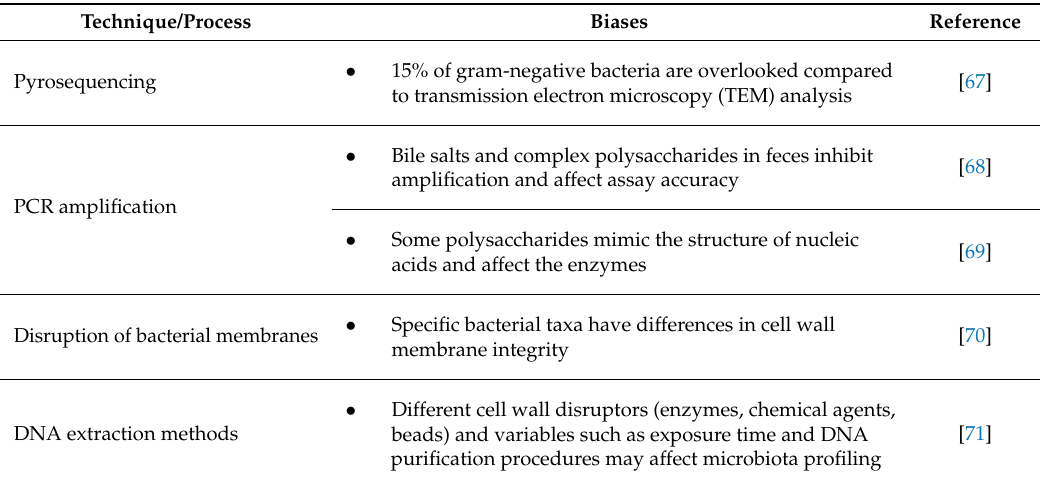
Table 3. Biases among molecular